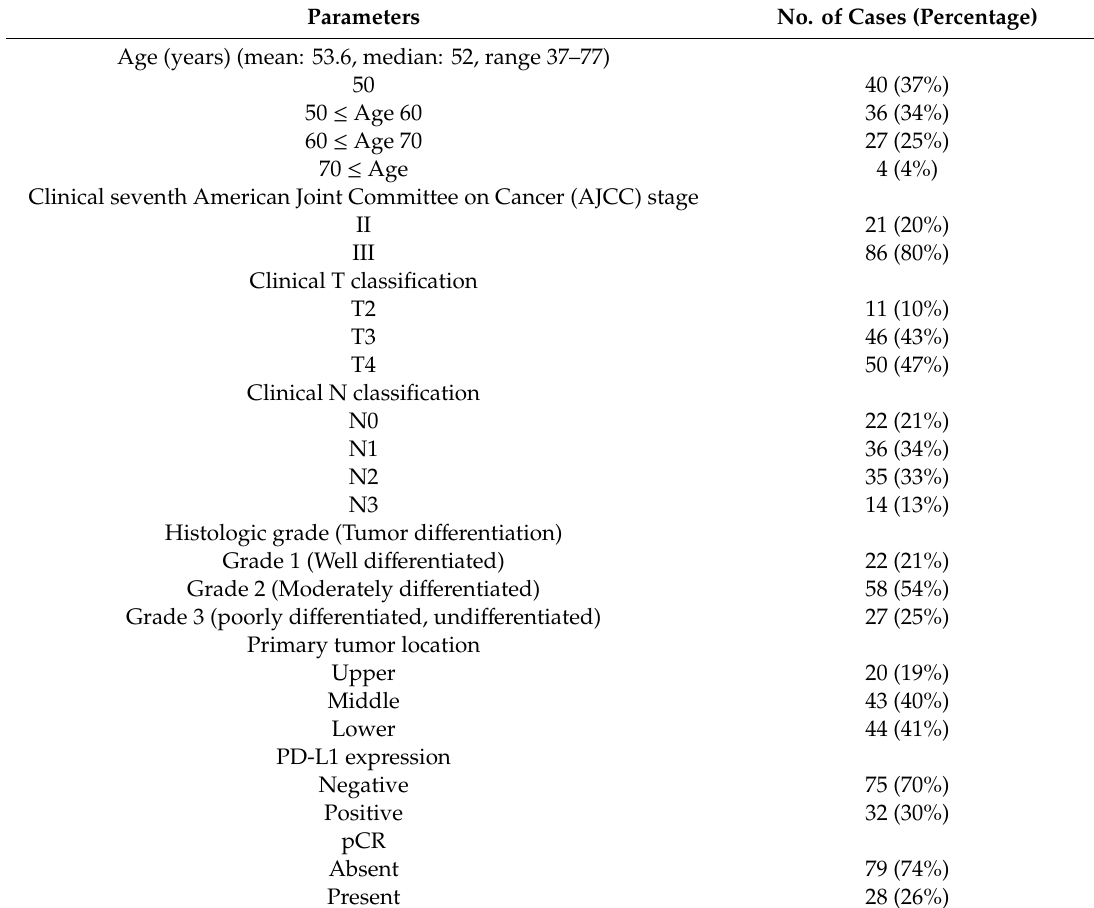
Table 1. Clinicopathologic features of 107 patients with locally advanced esophageal squamous cell carcinoma who received preoperative chemoradiotherapy.